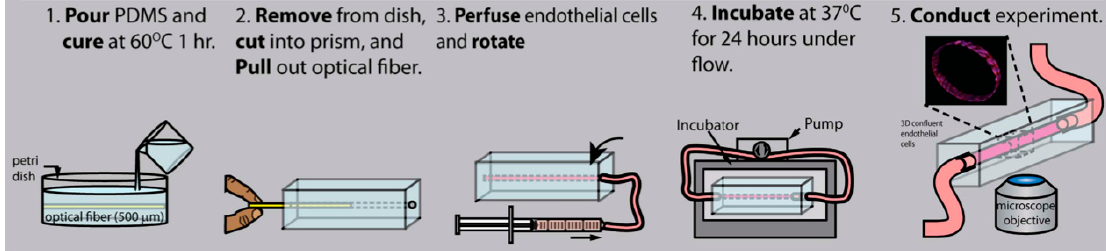
Figure 1. Fabrication steps using polymethyl methacrylate (PMMA) optical fibers in “top-down” fabrication. Adapted with permission from [44].